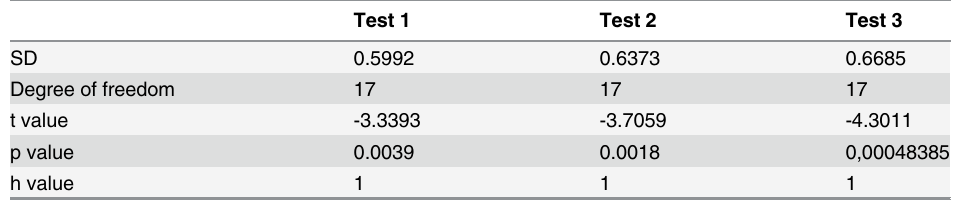
Table 8. Results of t-test for